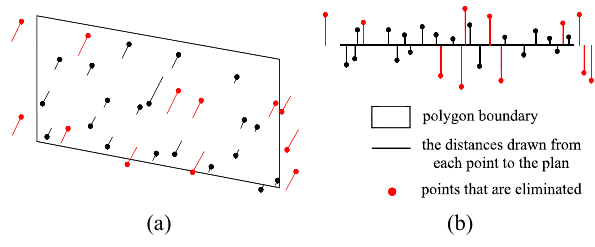
Figure 4. Calculating the distances drawn from each point to the plan (a) Perspective view (b) Top view 3.3.4 Calculating the Voronoi Diagram : In order to calculate the Voronoi diagram for the points that belong to a surface, Fortune’s algorithm was used.